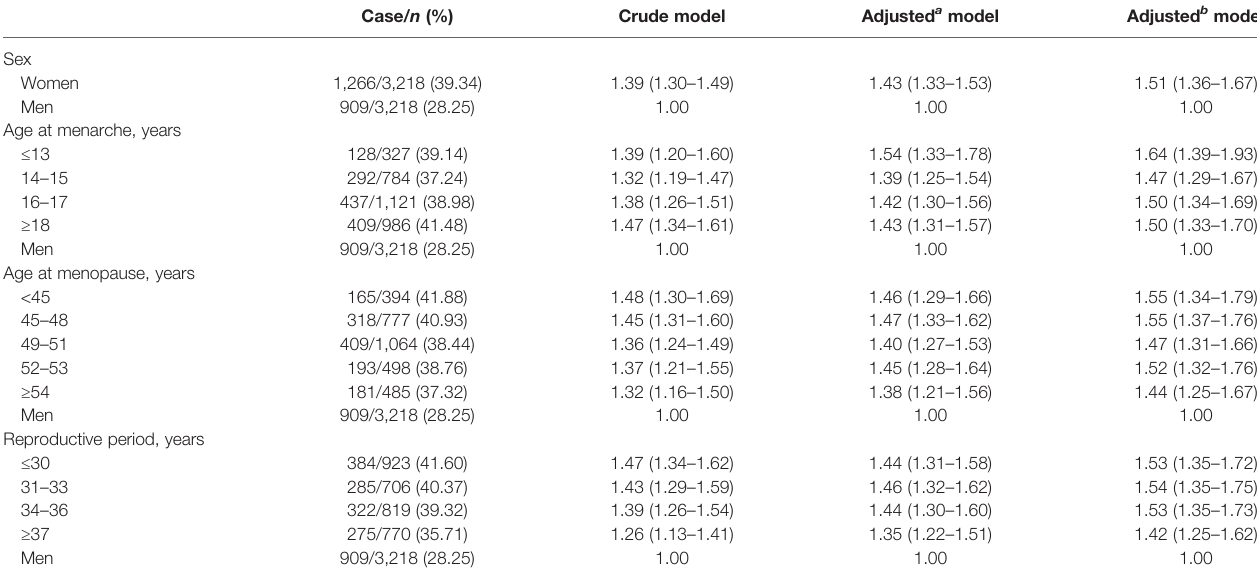
TABLE 3 | Association between sex, age at menarche, age at menopause, reproductive period, and subjective memory impairment ( n = 6,436). Case/ n